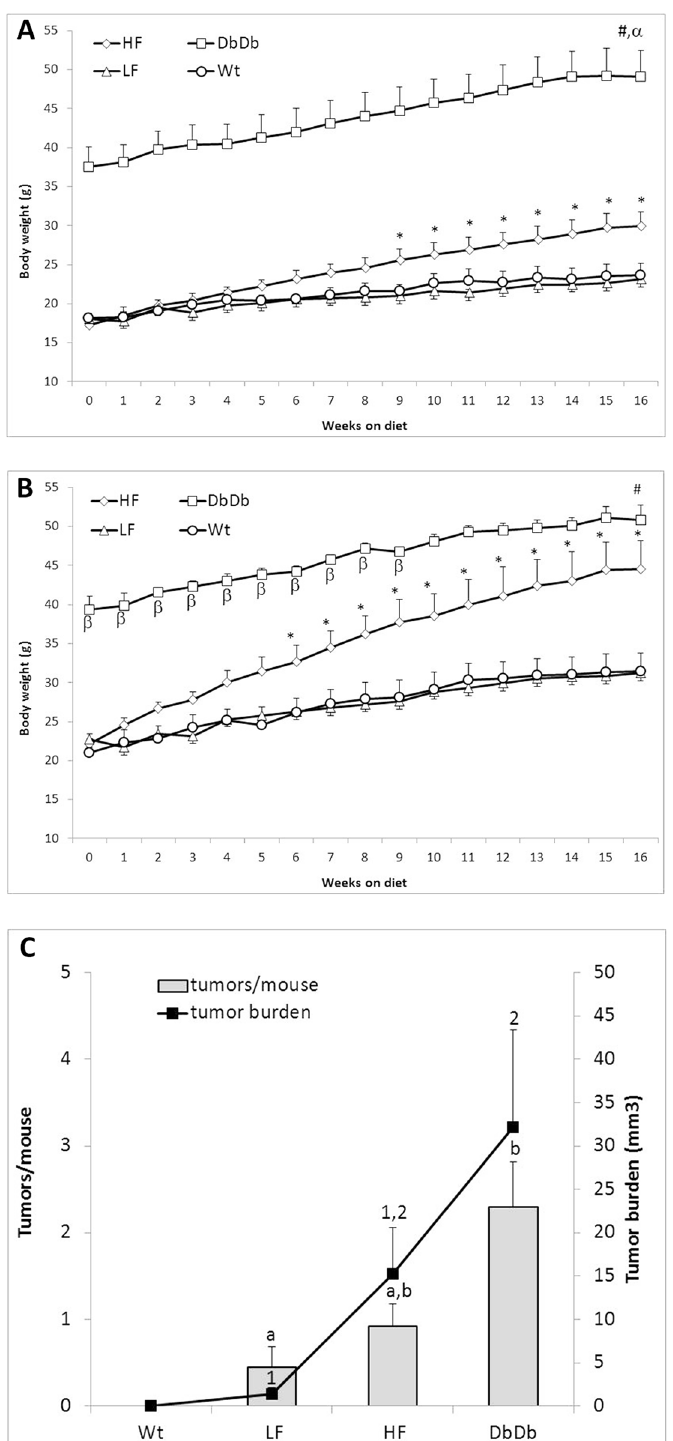
Fig 1. Effect of diet and genotype on body weight and tumor burden. A) Weight of female mice by group. * p < 0.05 vs. LF, # p < 0.05 vs. LF (all time points), α p < 0.05 vs. HF (all time points). B) Weight of male mice by group. * p < 0.05 vs. LF, # P < 0.05 vs. LF (all time points), β p < 0.05 vs. HF. C) Small intestinal tumor burden by group. p trend < 0.001 for tumor number and burden. Groups with different number are significantly different by post-test (p < 0.05).